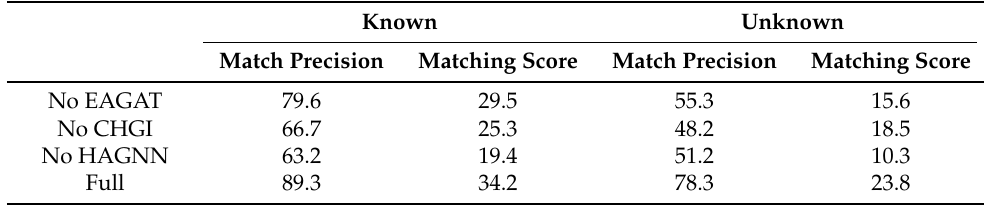
Table 4. Ablation of